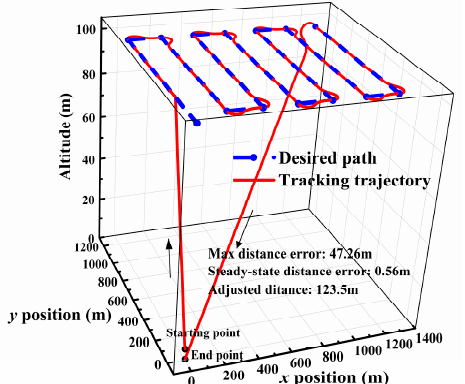
Figure 29. Flight trajectory of completing a multi-waypoint mission.